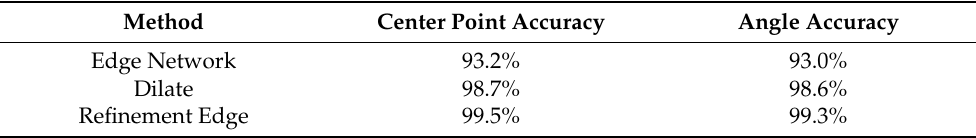
Table 4. Comparison of ablation experiments of different modules.